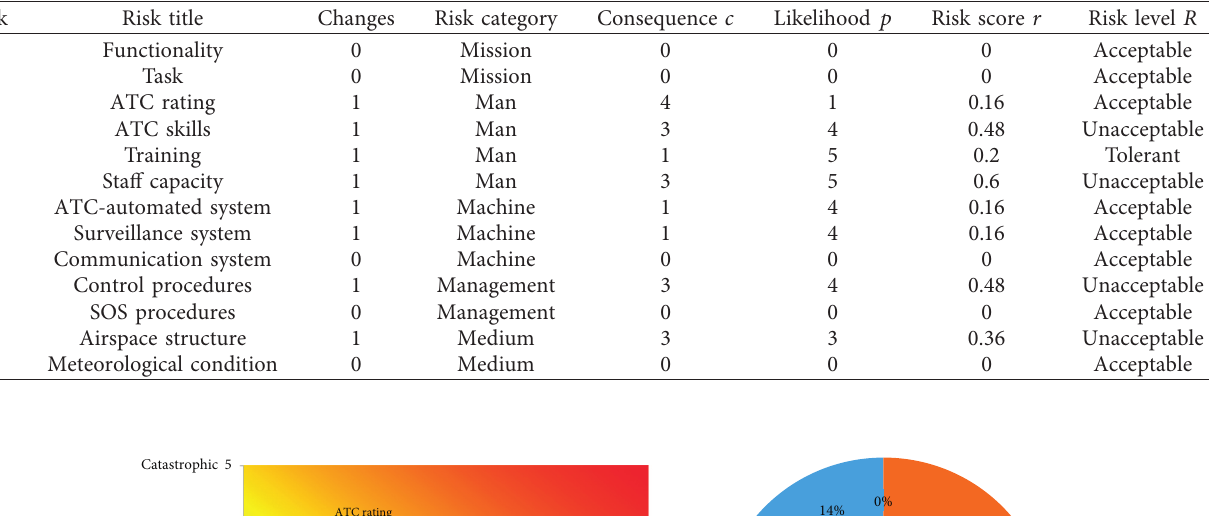
Table 4: Results of case study.